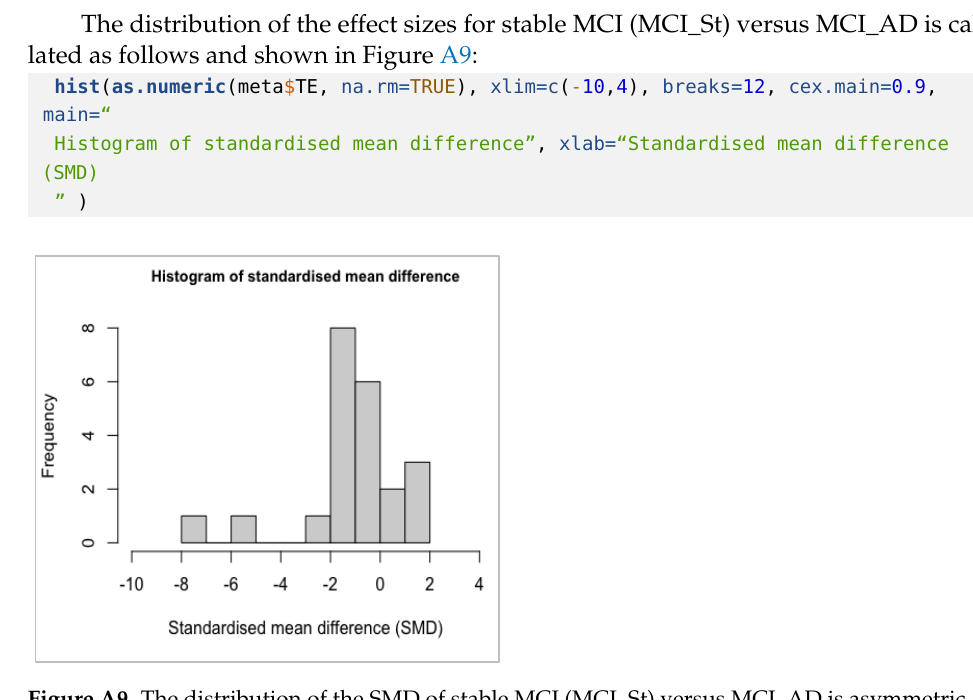
Figure A9. The distribution of the SMD of stable MCI (MCI_St) versus MCI_AD is asymmetric, but not too far from a normal distribution.